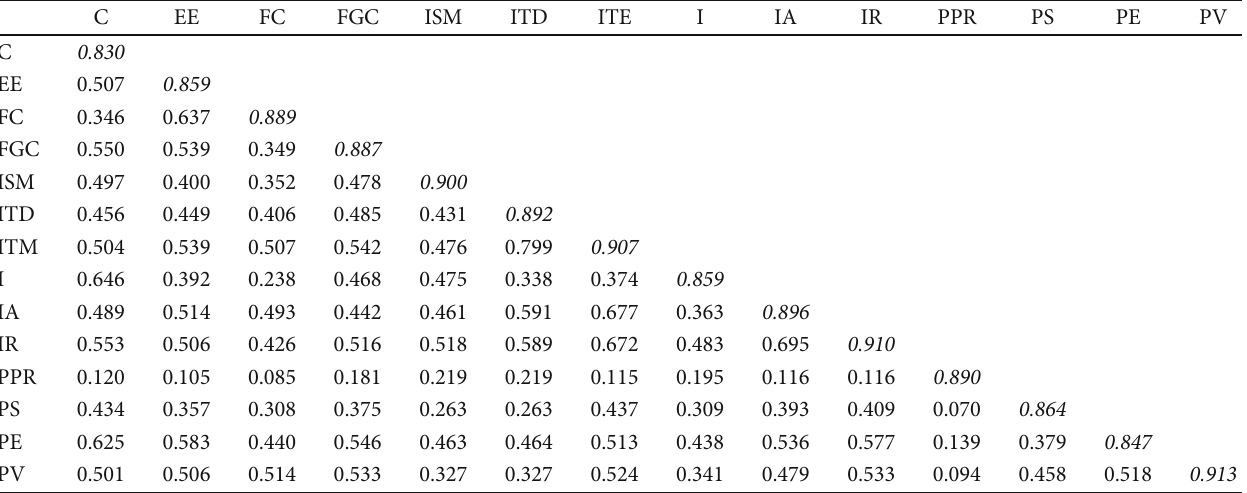
Table 10: Fornell-Larcker criterion: matrix of correlation constructs and the square root of AVE (in